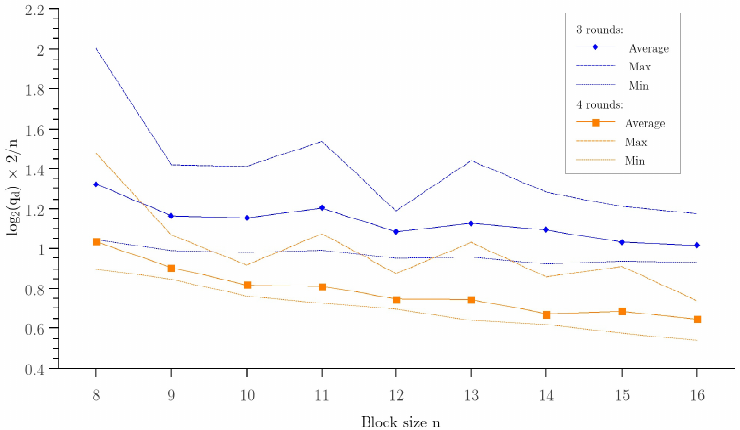
Figure 10: Experimental resilience of MOE n against differential attacks for small n